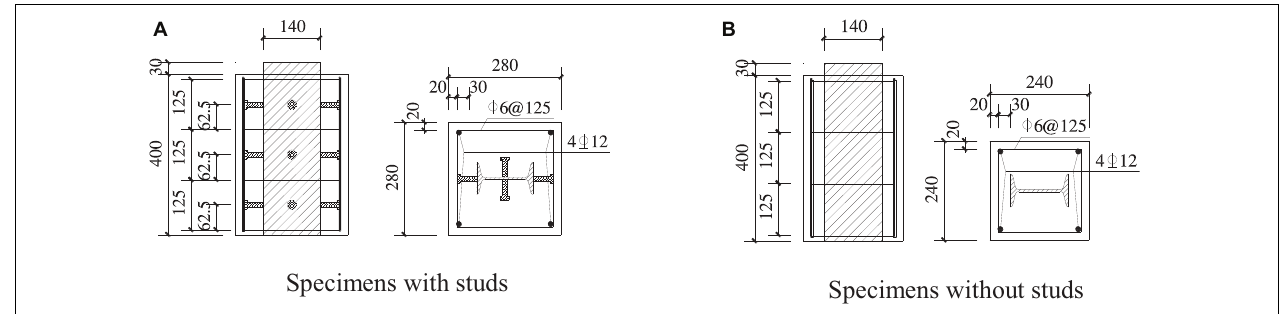
FIGURE 1 | Dimensions and configurations of specimens. (A) Specimens with studs. (B) Specimens without studs.